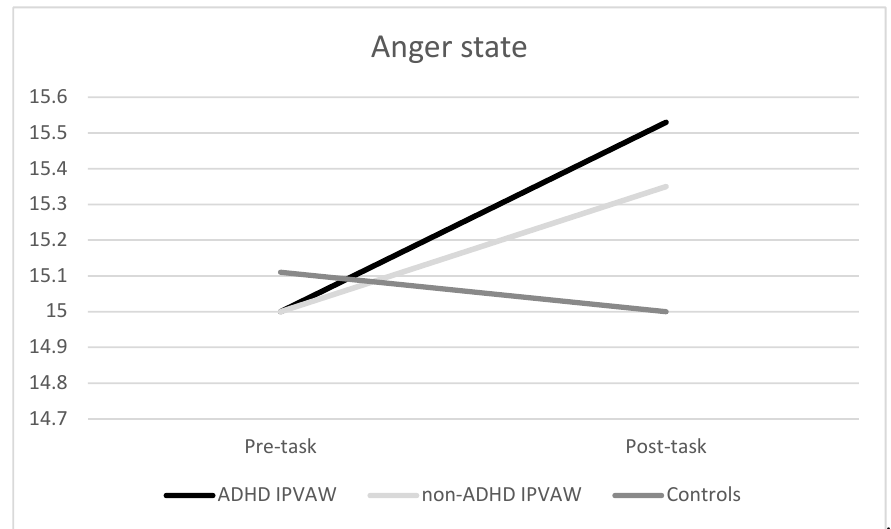
Figure 2. Anger state (State-Trait Anger Expression Inventory-2’ (STAXI-2)) changes before and after exposure to the acute laboratory stressor for all groups. ADHD: Attention Deficit Hyperactivity Disorder; IPVAW: Intimate Partner Violence Against Women.